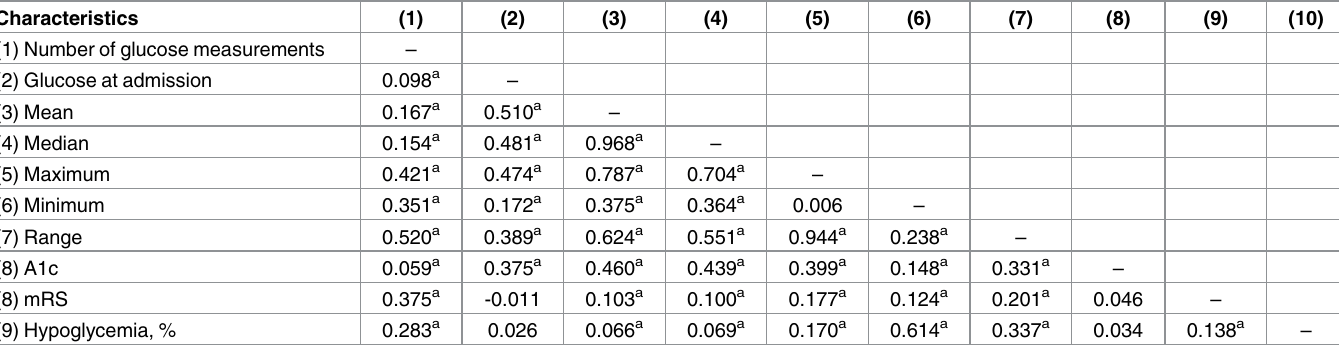
Table 2. Matrix of correlation coefficient among crude modified Rankin Scale score, hypoglycemia rate and glucose parameters.